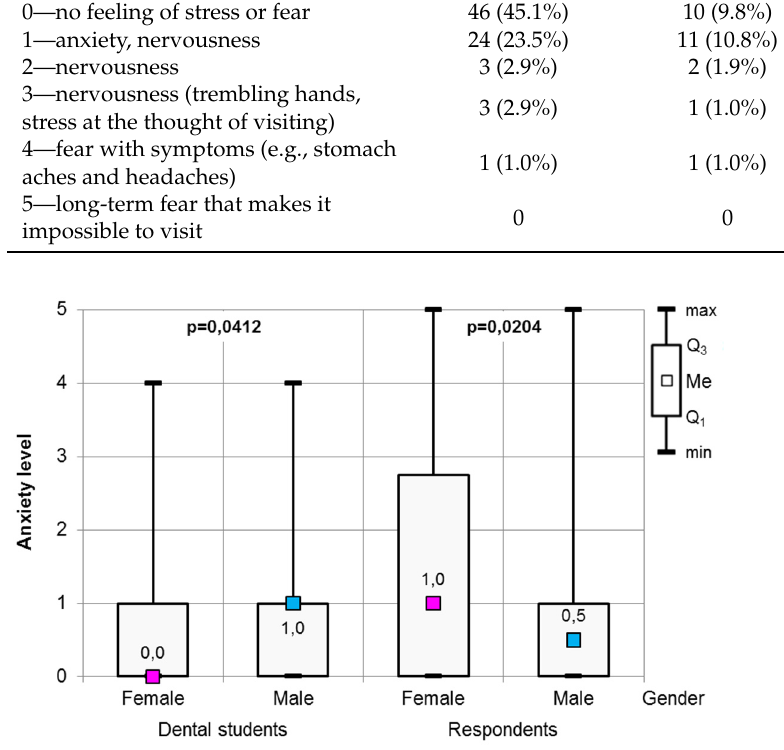
Figure 2. The results of the Mann–Whitney test for dental anxiety scale in terms of participants’ gender.